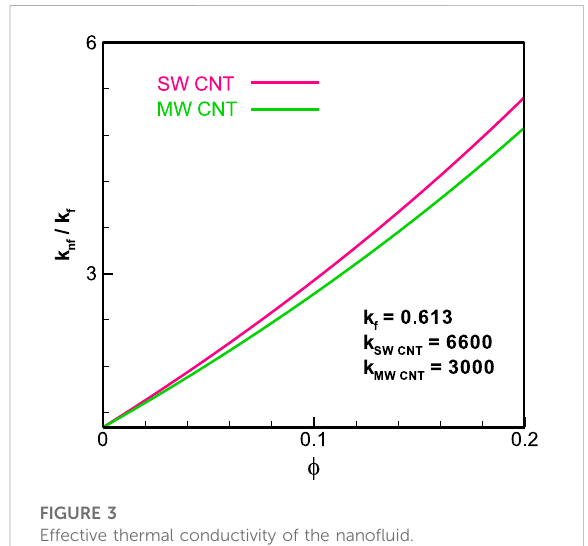
FIGURE 3 Effective thermal conductivity of the nano fl